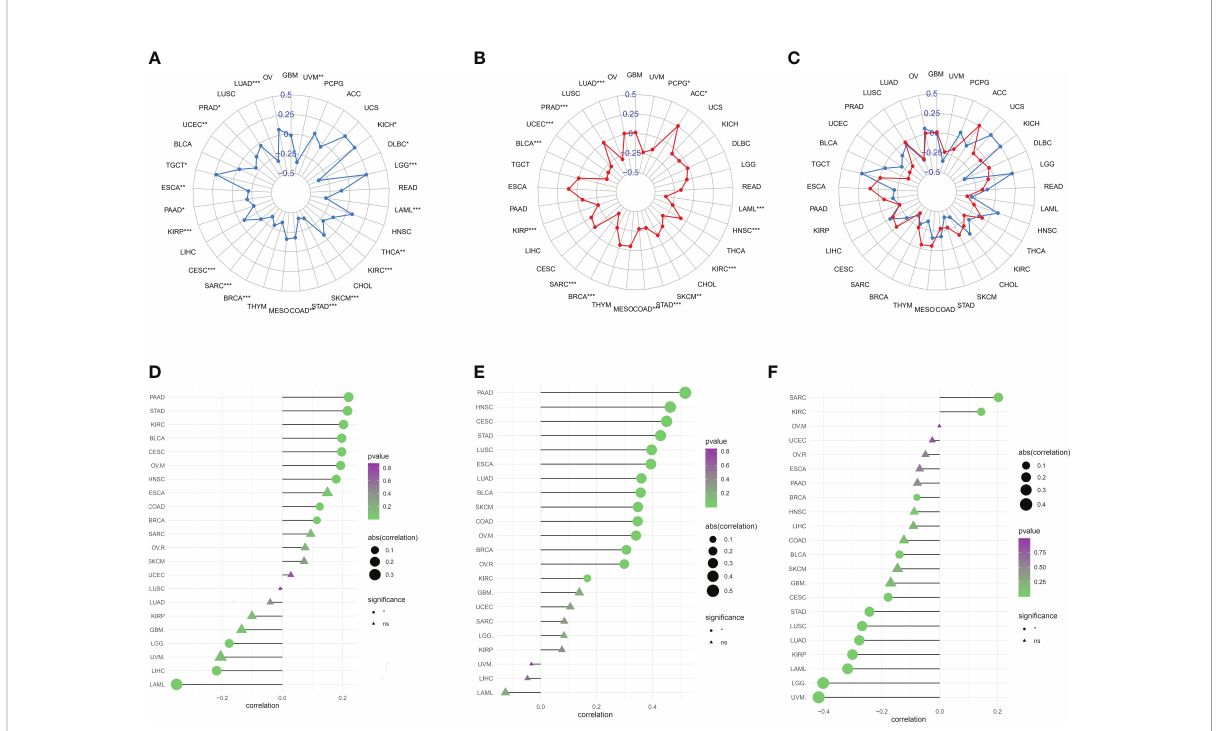
FIGURE 8 Migrasome scores are closely related to microsatellite instability (MSI) and tumor mutational burden (TMB). (A) Correlation between migrasome scores and TMB in human cancers. *P < 0.05, **P < 0.01, ***P < 0.001. (B) Correlation between migrasome scores and MSI in human cancers. The Spearman ’ s correlation coef fi cient and p-value are shown in the radar plot. *P < 0.05, **P < 0.01, ***P < 0.001. (C) Correlation of migrasome scores with TMB and MSI. The blue line represents TMB and the red line represents MSI. (D) Correlation between migrasome scores and tumor immune dysfunction and exclusion (TIDE). The higher the TIDE scores, the higher the chance of tumor immune escape. (E) Correlation between migrasome scores and TIDE in the high TIDE group. (F) Correlation between migrasome scores and TIDE in the low TIDE group. ns, no signi fi